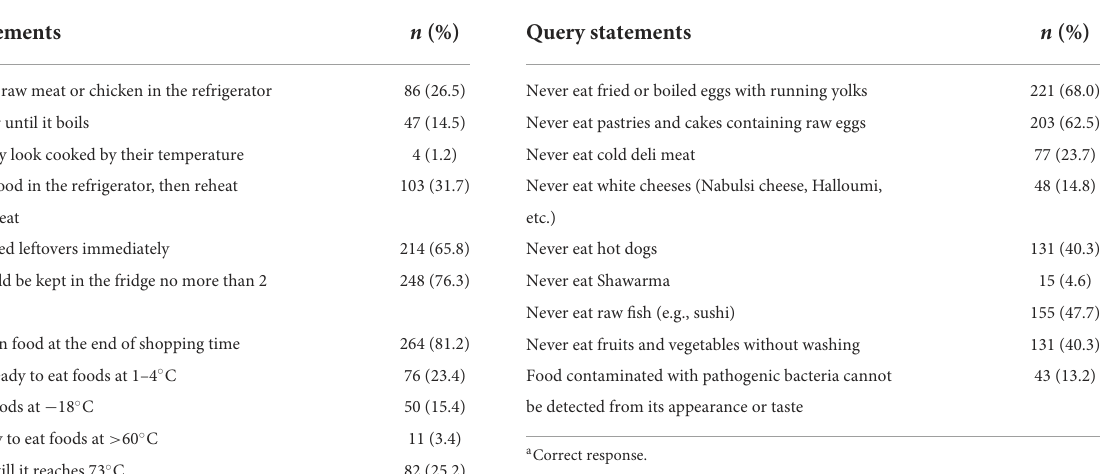
TABLE 5 Query statements and responses a of the “temperature control” domain ( n = 325).